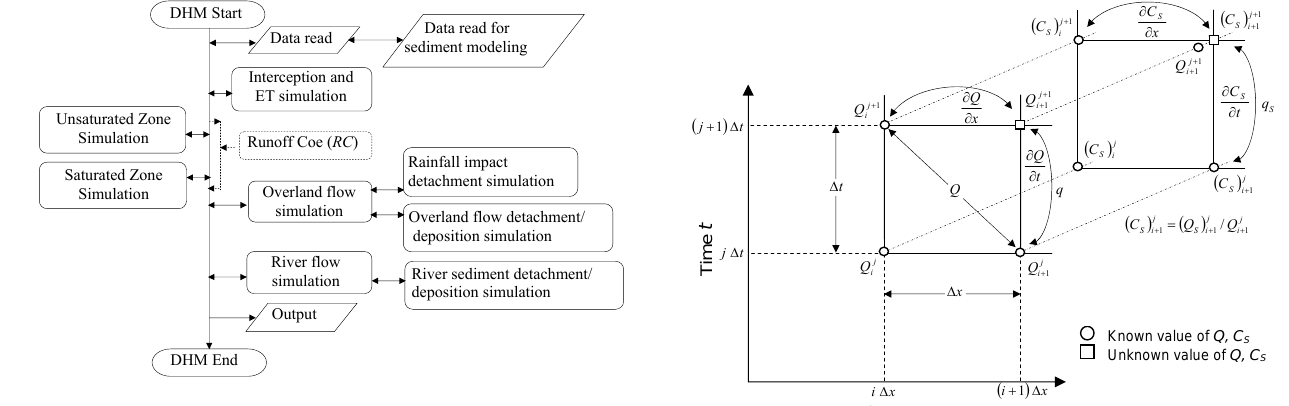
Fig. 2. Structure of the process-based sediment dynamic model.